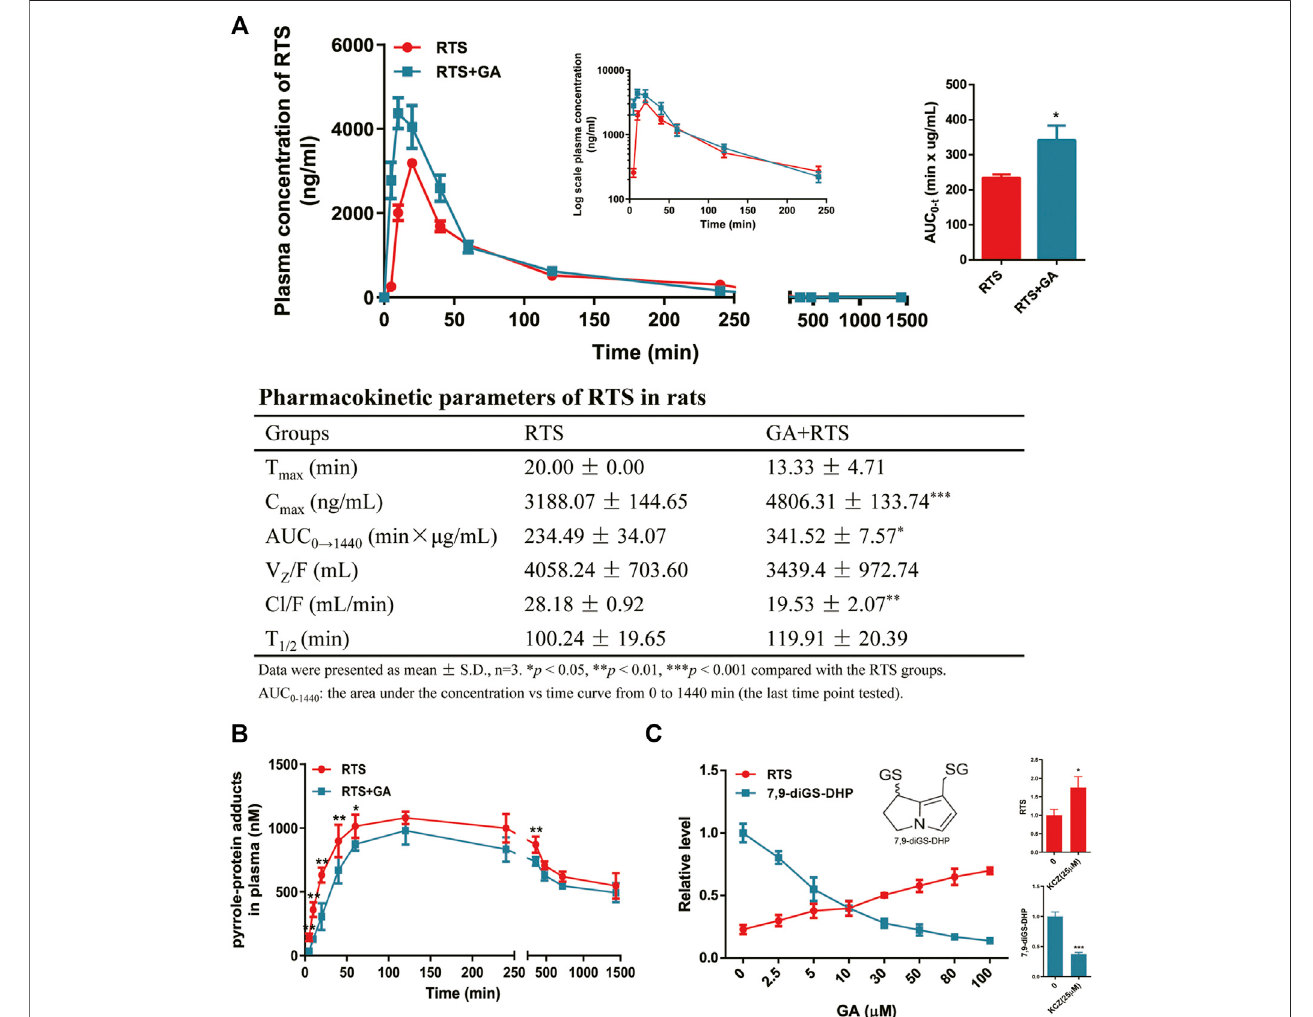
FIGURE5| GAinhibited metabolic activation ofRTSboth in vivo and invitro . Plasma kineticpro fi les, AUC, and pharmacokineticparameter ofRTS (A) and plasma kinetic pro fi les of pyrrole-protein adducts (B) in RTS-treated rats orally dosed with vehicle or GA. Concentration changes of RTS and 7,9-diGS-DHP in the rat liver microsome incubation of RTS with GA (0 – 100 µM) or ketoconazole (KCZ, 25 µM) (C) . Data are expressed as mean ± SD ( n = 3). * p < 0.05, ** p < 0.01, and *** p < 0.001 versus the corresponding RTS group.